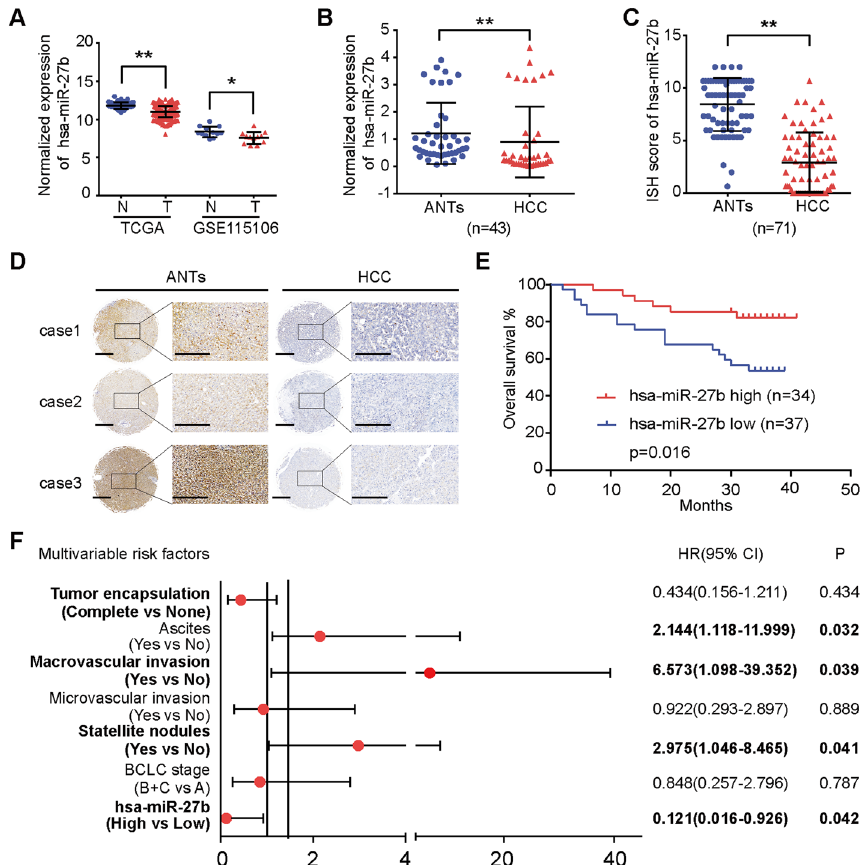
Fig. 1 Hsa-miR-27b is downregulated in HCC specimens, and low expression of hsa-miR-27b predicts poor prognosis. A Hsa-miR-27b expression in HCC samples and normal liver tissues was analysed using TCGA (HCC, n 370; normal liver, n 50; unpaired t -test) and GSE115016 (HCC, n 12; normal liver, n 12; unpaired = = = = t -test) datasets. B qRT-PCR analysis of the expression of hsa-miR-27b in HCC and adjacent non-tumourous tissues (ANTs) (Mann–Whitney test). Data were normalized to U6 and are shown as the fold change compared with patient 7. C ISH scoring of hsa-miR-27b in 71 pairs of HCC tissues (Mann–Whitney test). D Representative ISH images of hsa-miR-27b in paired HCC samples. Scale bar: overview images, 100 μm; magnified images, 200 μm. E Kaplan–Meier analysis of the correlation between hsa-miR-27b expression and overall survival in the cohort of patients with HCC (log-rank test). F Forest plot of the multivariate Cox proportional hazards model for overall survival. The bars correspond to 95% confidence intervals. * p < 0.05; ** p < 0.01. Data are shown as mean SD. T, tumour; N, normal liver; ANTs, adjacent non-tumourous tissues; HCC, hepatocellular ± carcinoma; HR, hazard risk; CI, confidence